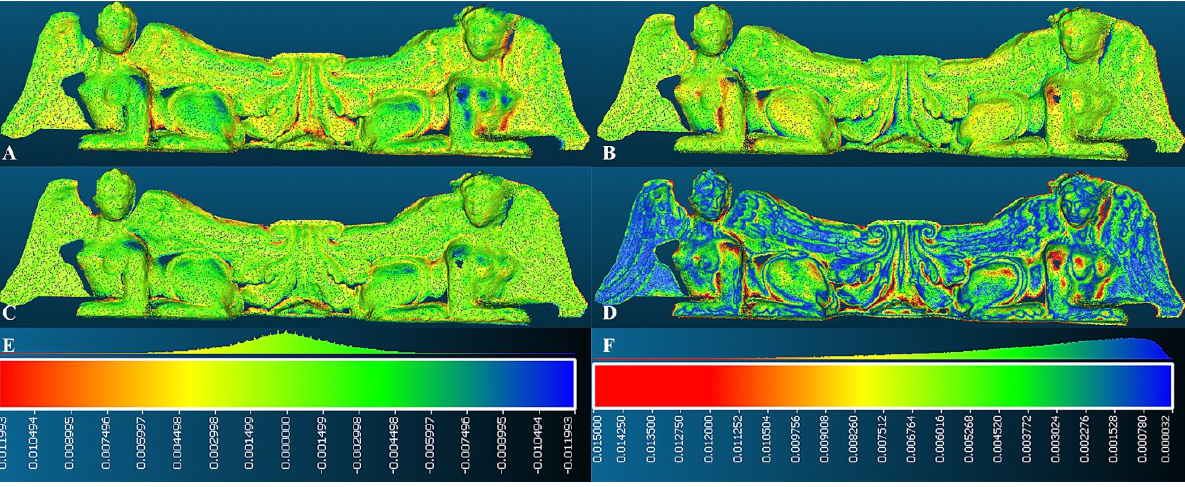
Figure 8. Deviations between point cloud form TLS and Xiaomi 4K camera for figures of winged female sphinxes) X value, B) Y value, C) Z value and D) linear value.